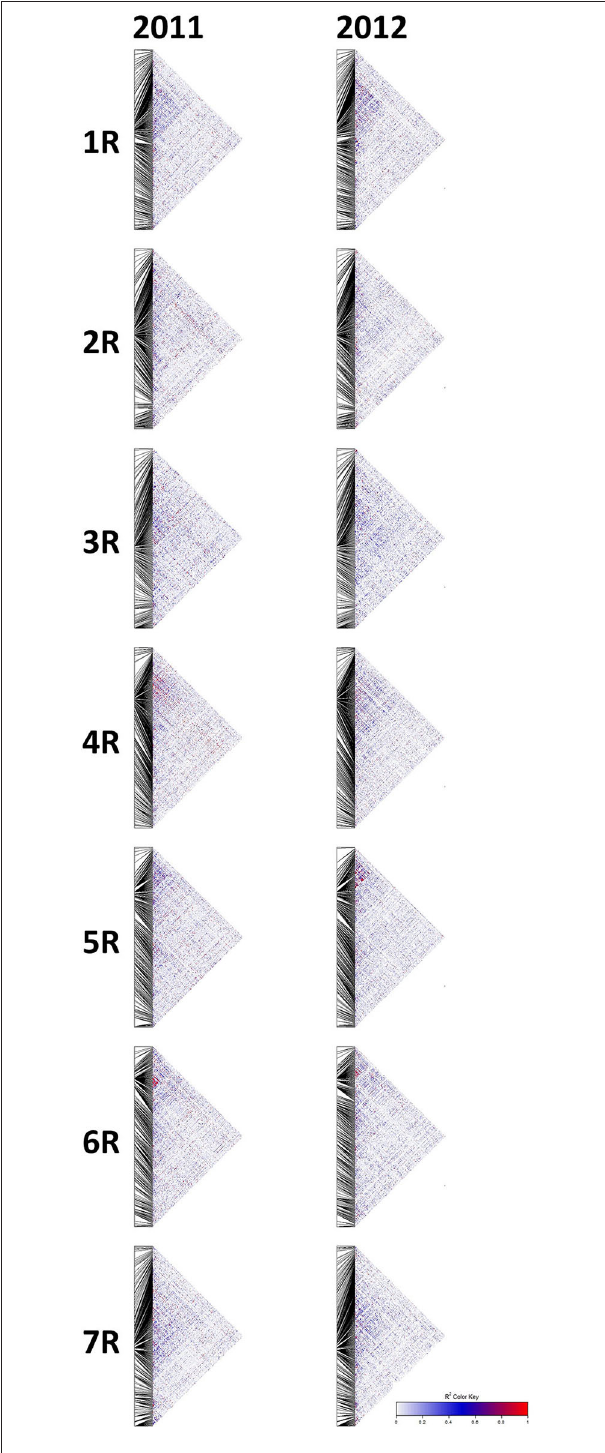
FIGURE 7 | Heatmaps of squared allele frequency correlation values (r 2 vs ) corrected by relatedness of genotyped individuals and the structure of the sample to display intra-chromosomal linkage disequilibrium (LD) for both germplasm collections. r 2 vs in experimental hybrid rye genotypes based on 2,563 and 2,790 polymorphic SNP markers identified by DArTseq TM . The color legend for r 2 vs values is given on the right side.